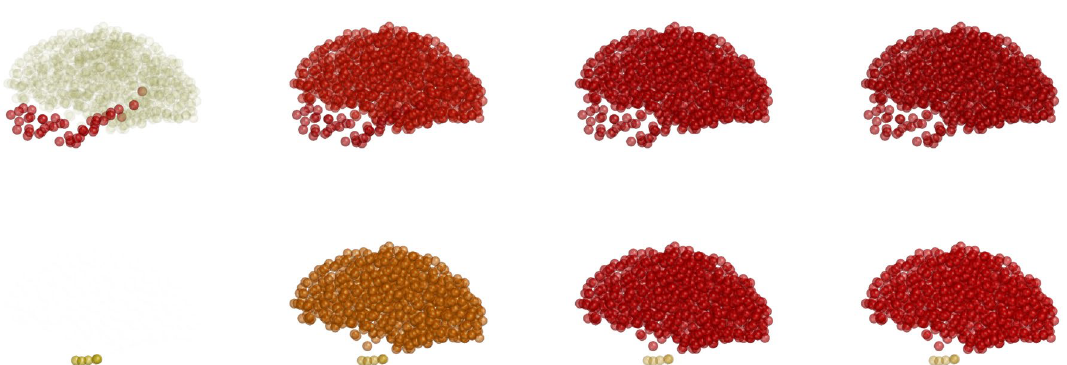
Figure 3. (Color online) Toxic A β and toxic τ P concentrations in the brain connectome at different times (left to right: t = 50, 75, 85 and 100) for the local model corresponding to the primary tauopathy. Upper and lower panels are corresponding to toxic A β and toxic τ P,